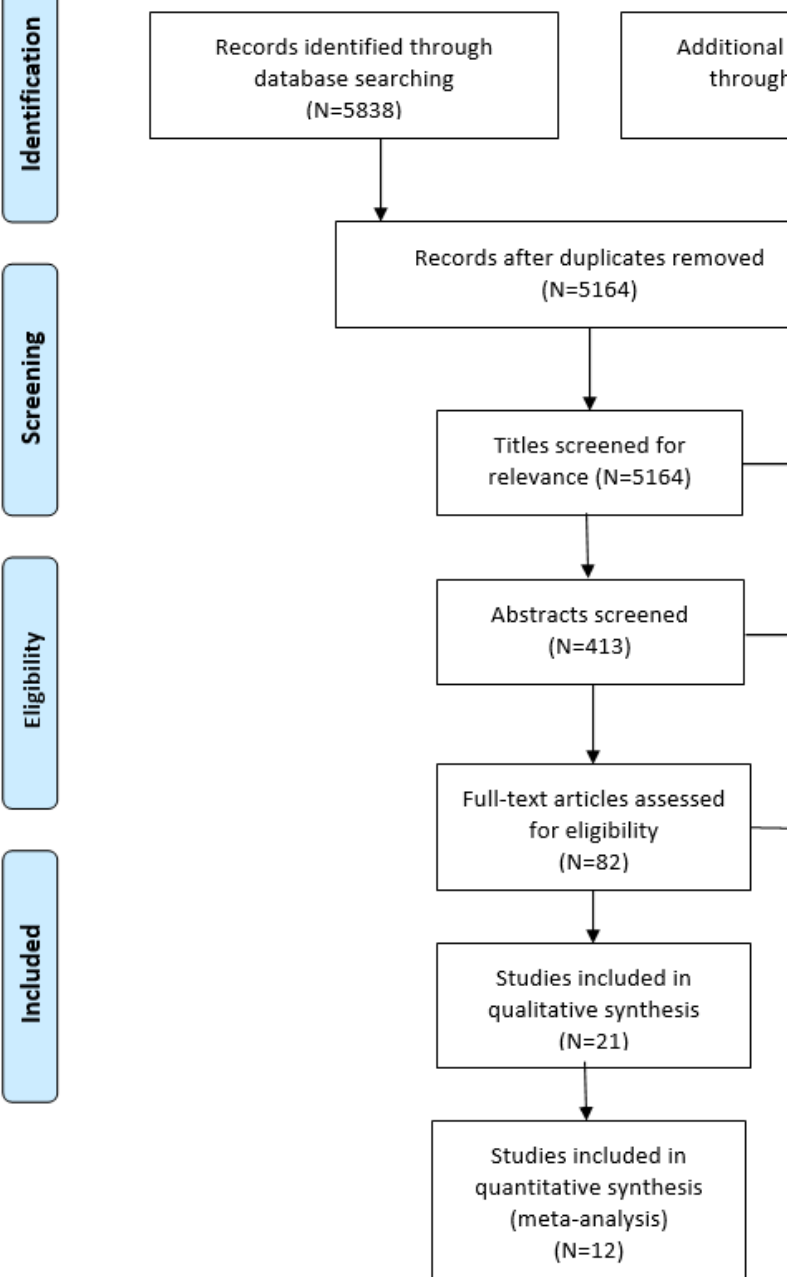
Figure 2. Process of the systematic literature review using a PRISMA flow diagram. PRISMA: Preferred Reporting Items for Systematic Reviews and